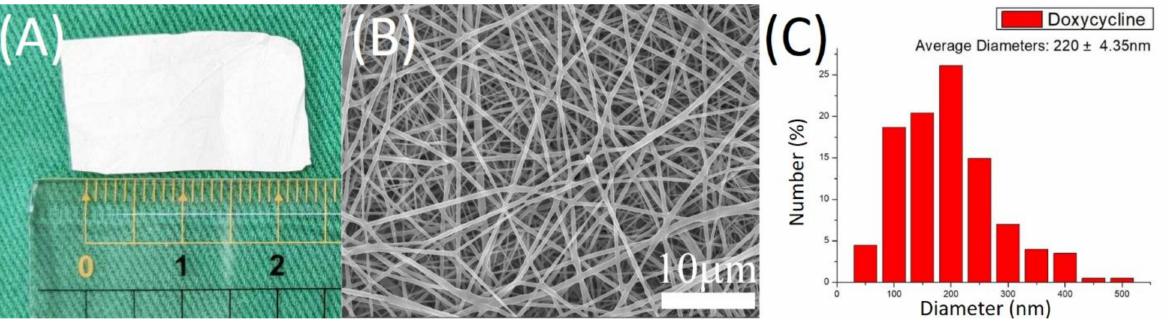
Figure 3. ( A ) Gross view; ( B ) scanning electron microscope (SEM) image of doxycycline-loaded poly-D-L- lactide-glycolide (PLGA) nanofibrous membranes (magnification: × 5000); ( C ) size distribution of